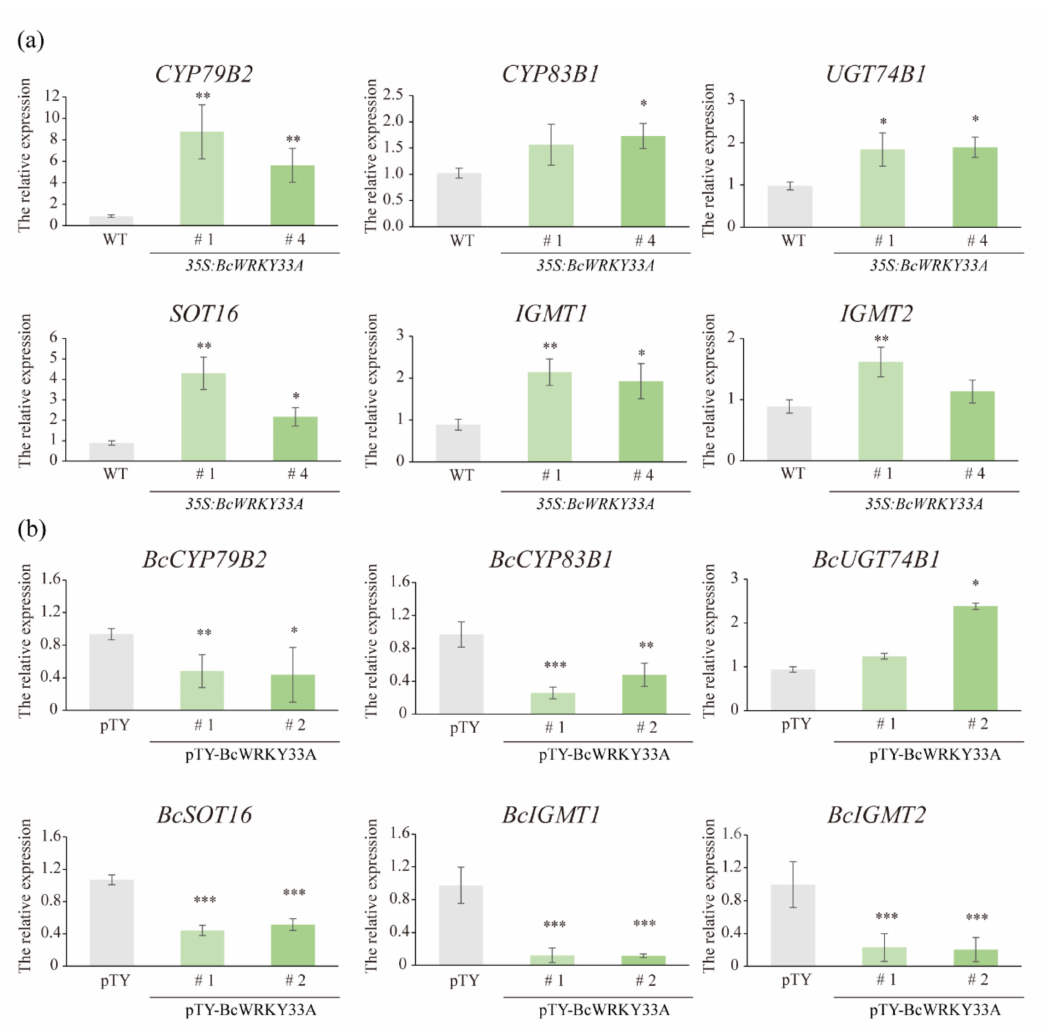
Figure 2. BcWRKY33A mediates the abundance of IGSs’ biosynthetic genes. ( a ) The relative expres- sion level of IGSs’ biosynthetic genes in WT and 35S:BcWRKY33A lines. ( b ) The relative expression level of IGSs’ biosynthetic genes in pTY and pTY-BcWRKY33A plants. Error bars represent SD. Data are means ± SD of three biological replicates. The significant differences in genes’ relative expression were measured based on Student’s t -test (* p < 0.05, ** p < 0.01, *** p <